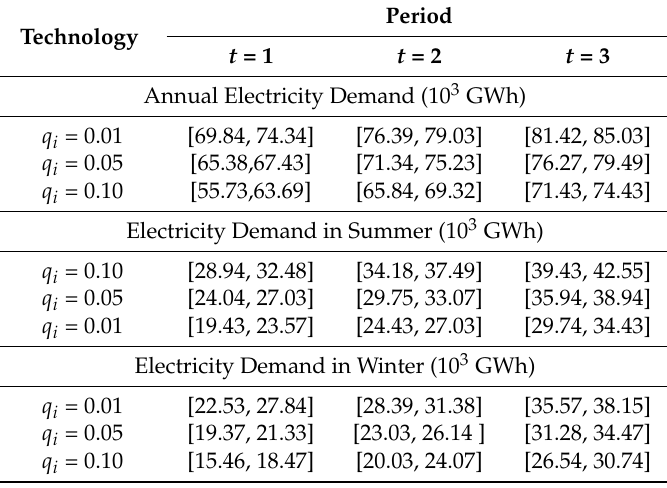
Table 3. Electricity demand under different q i levels.